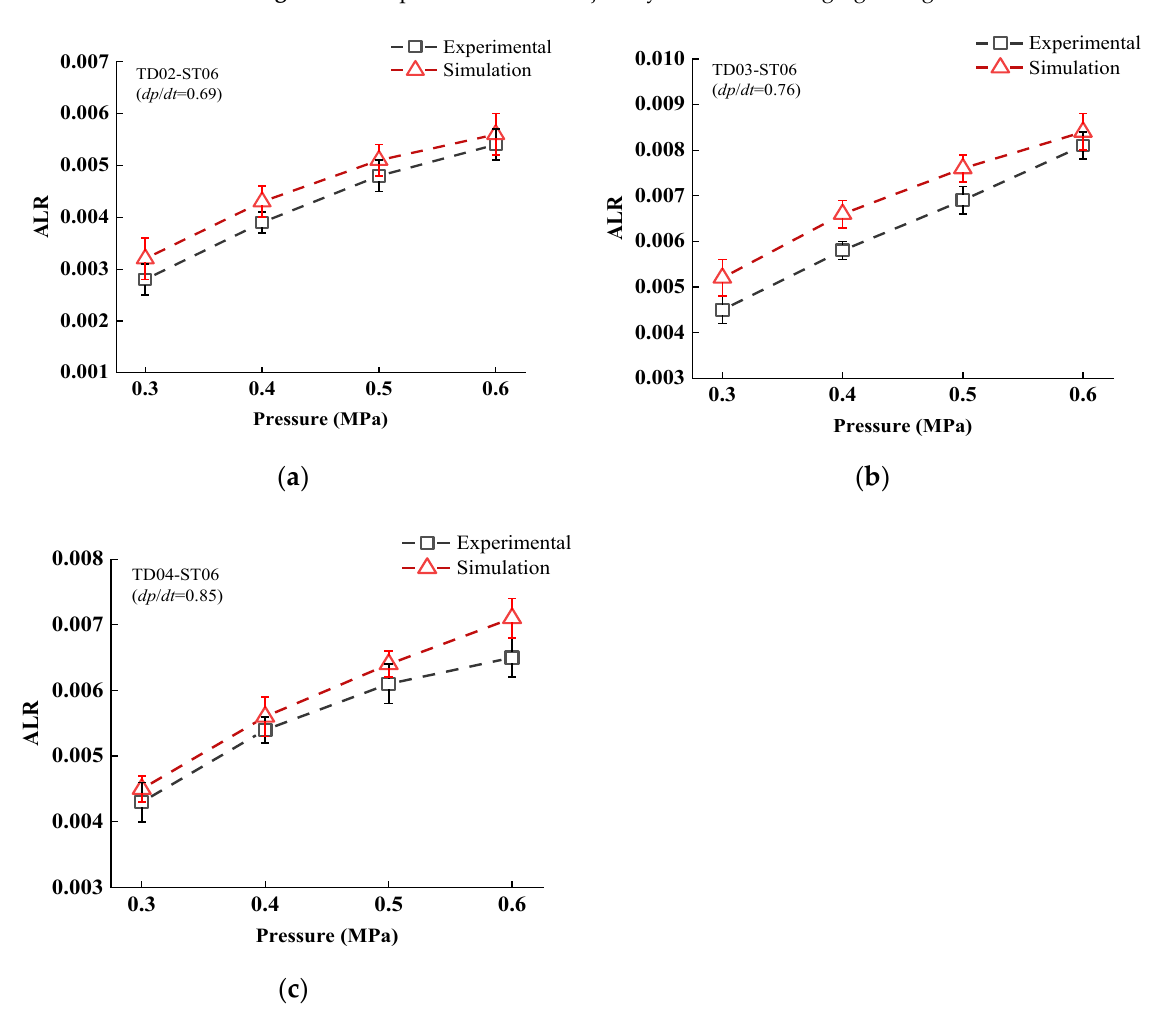
Figure 11. Droplets movement trajectory at different charging voltage.